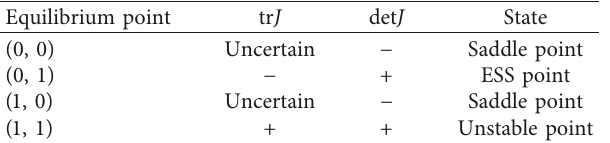
Table 3: Evolutionary stability of local equilibrium points in Scenario II.